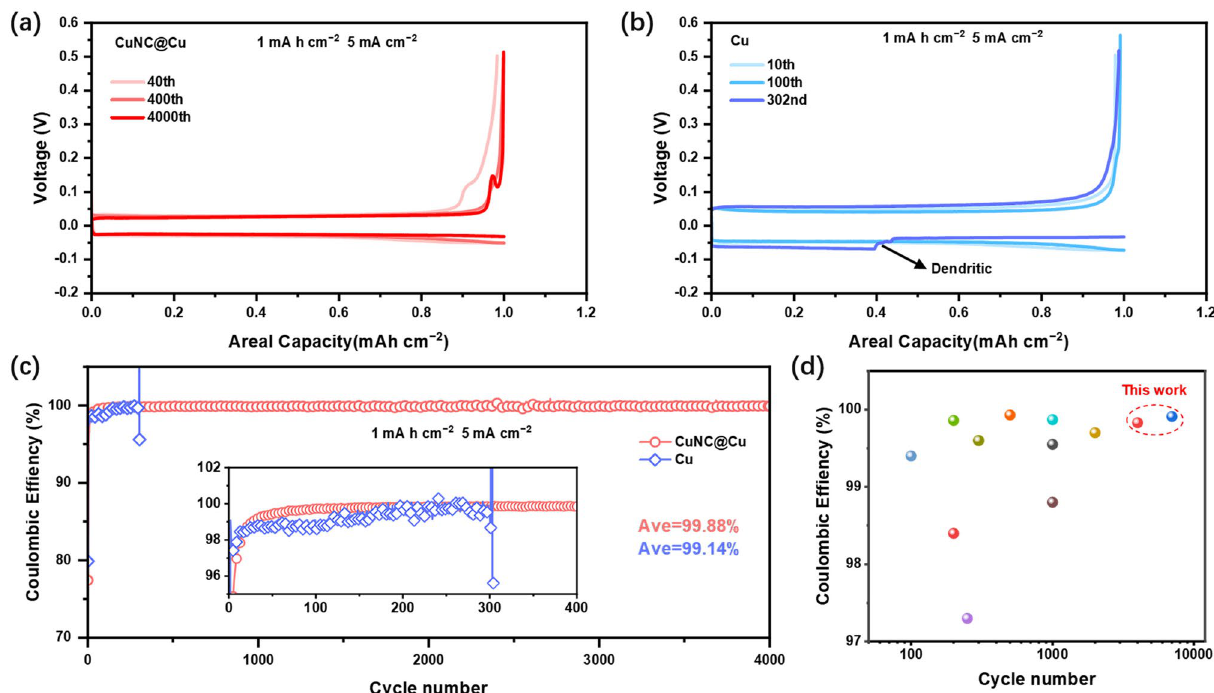
Fig. 4 Galvanostatic Zn deposition/dissolution curves of a CuNC@Cu and b Cu electrodes at selected cycles. c CE of Zn deposition/dissolution on CuNC@Cu and Cu electrodes at moderate conditions (1 mAh cm −2 and 5 mA cm −2 ). d Comparison of ACE and cycle stability of this work with recently reported Zn half